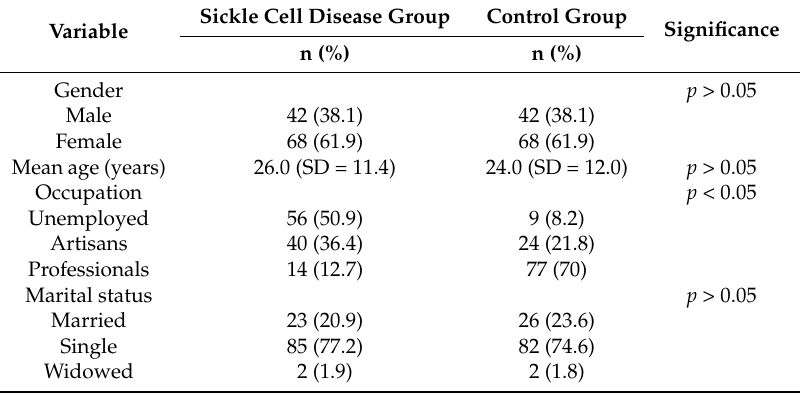
Table 1. Demographic features of the study